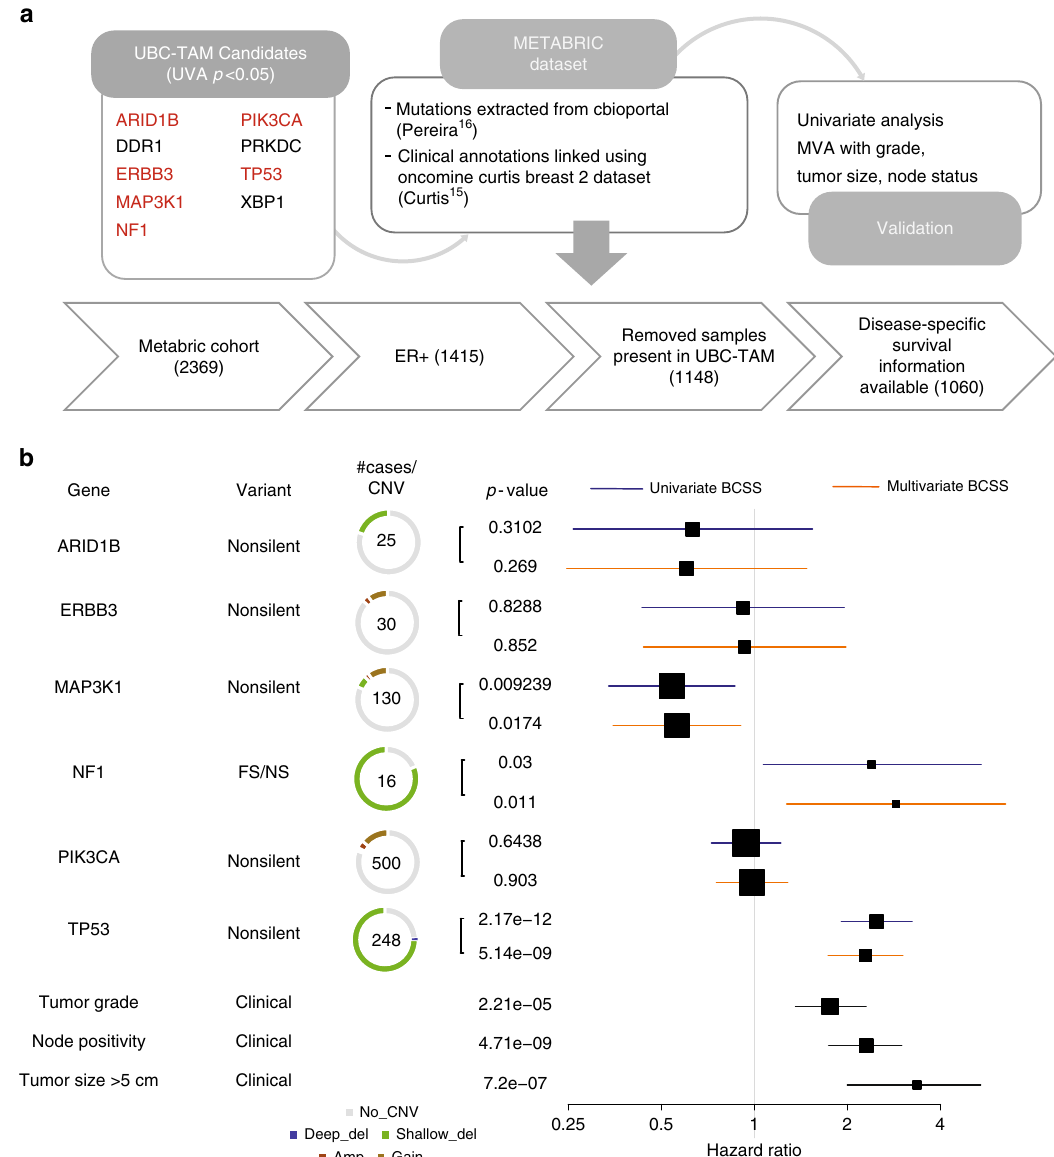
(mean = 48.2%) were signi fi cantly higher than the other genes ( p = 0.002, p = 0.0015, and 5.27e-5, respectively). Among the